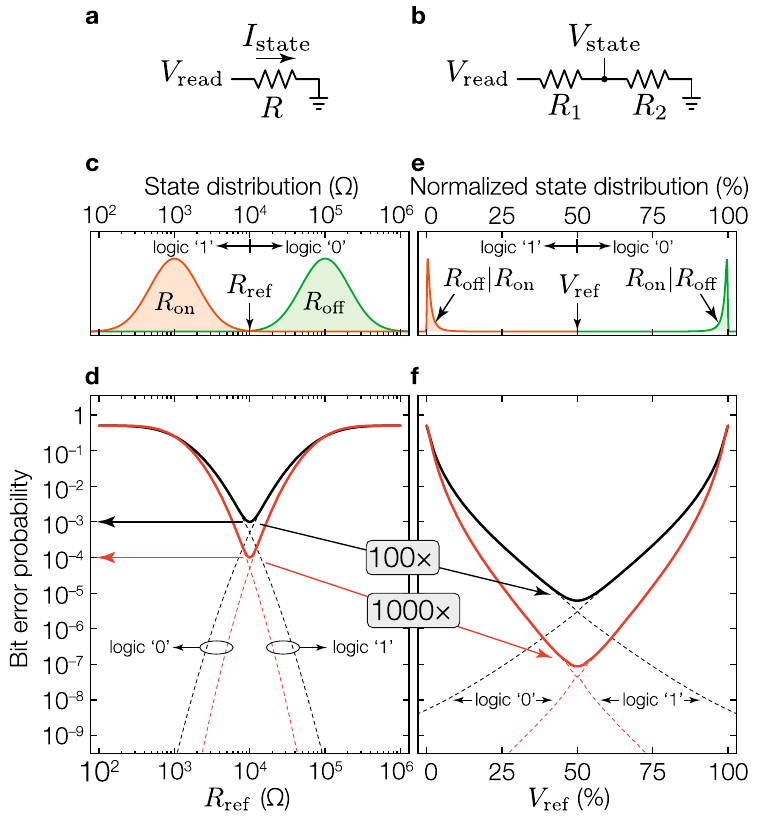
Figure 1. Memory encoding comparison in a two-level cell. ( a ) Configuration used to encode and read a cell using ReBE. ( b ) Voltage divider configuration used to encode and read a cell using RatioBE. ( c ) State distribution of the lowest ( R on ) and highest ( R off ) resistance states. d , BEP using the traditional resistance-based approach as a function of the reference in ohms. ( e ) State distribution under RatioBE. ( f ) BEP for the RatioBE as a function of the normalized reference. For both ( d ) and ( f ) the dashed lines represent the expected